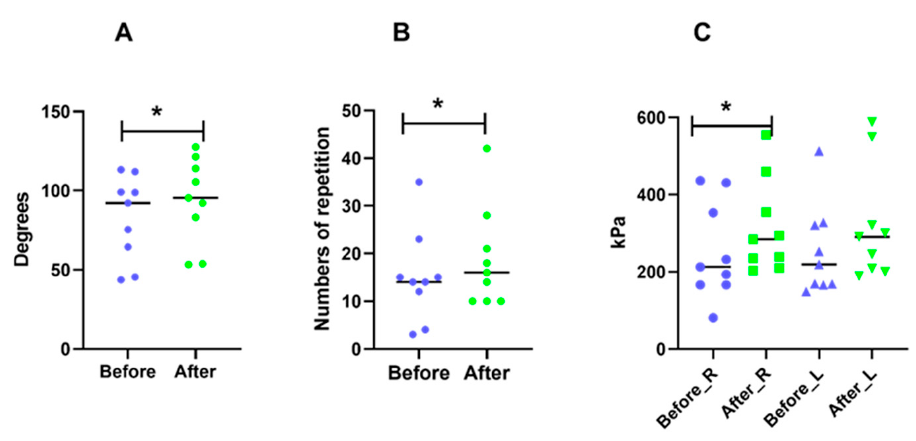
Figure 4. Statistical analysis of physiological markers Neck strength ( A ), shoulder strength ( B ) and pain pressure threshold (PPT) ( C ) for all subjects are shown. * indicates statistical significance ( p < 0.05) differences between before dynamic computer working (DCW) (blue dots) and after 4-weeks DCW (green dots) using DynaDesk. R refers to right side trapezius muscle and L refers to left side trapezius muscle. The median of the data is marked in the figure.